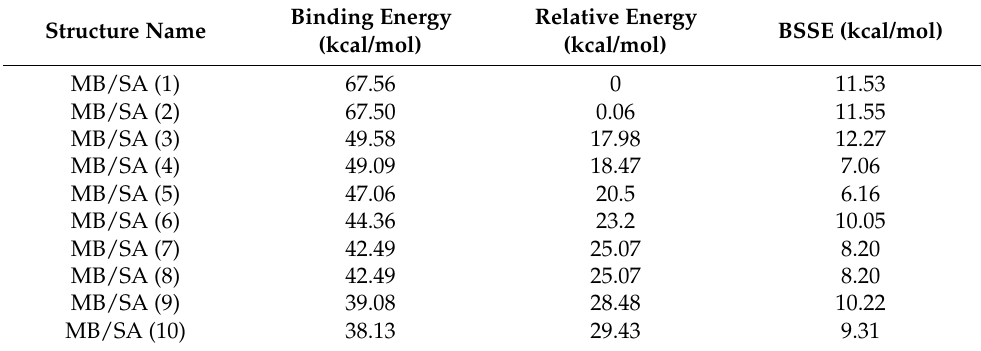
Table 1. Binding energy (in kcal/mol) for the MB/SA complexes characterized at the B3LYP/6- 31G(d) level.